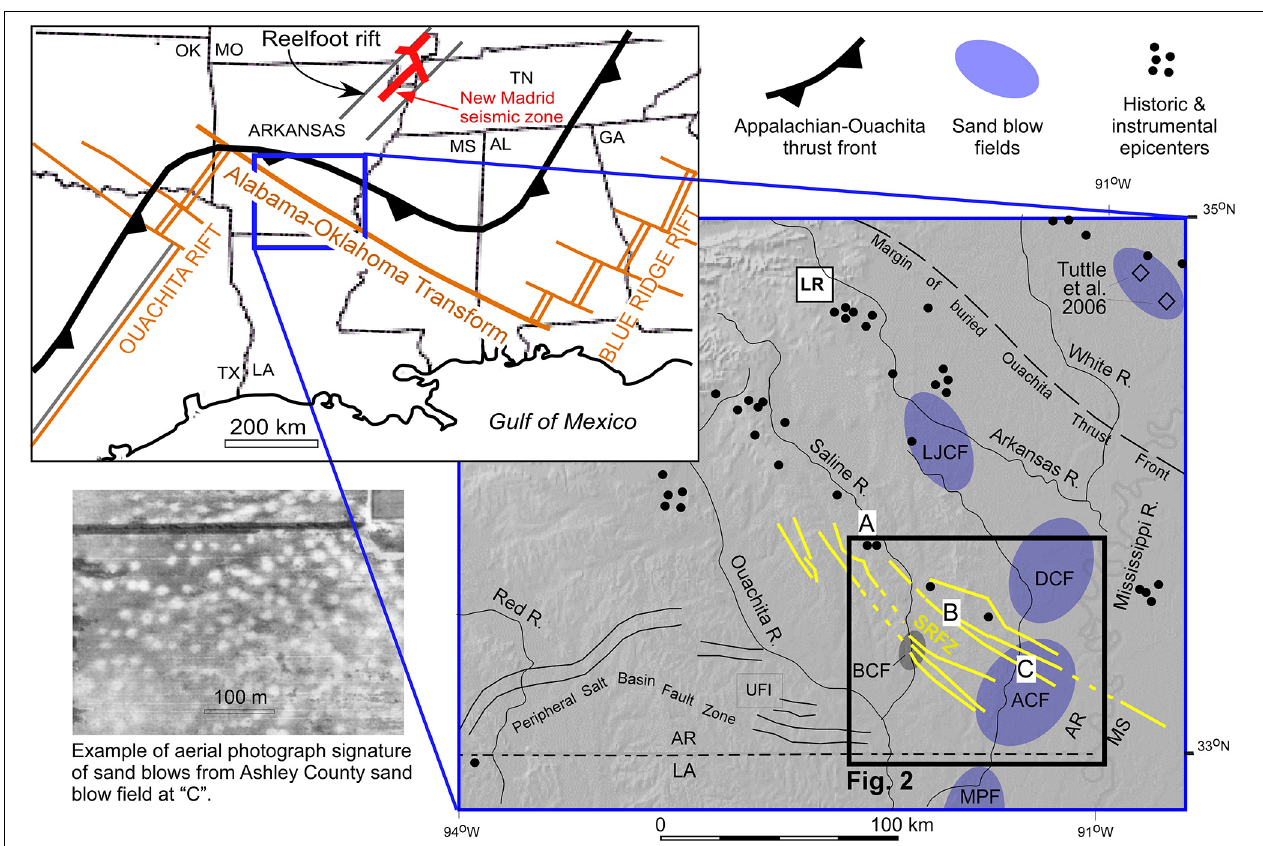
FIGURE 1 | Location map showing the general tectonic setting (upper left), a shaded-relief map showing the study area, and an aerial photograph ofsandblowdepositsatletter“C”(lowerleftofshadedrelief map). Compiled from Cox et al. (2010, 2013a). A, Holocene fault in Cleveland County, AR; B, Holocene fault in Drew County, AR; C, ∼ AD 1300 sand blow in